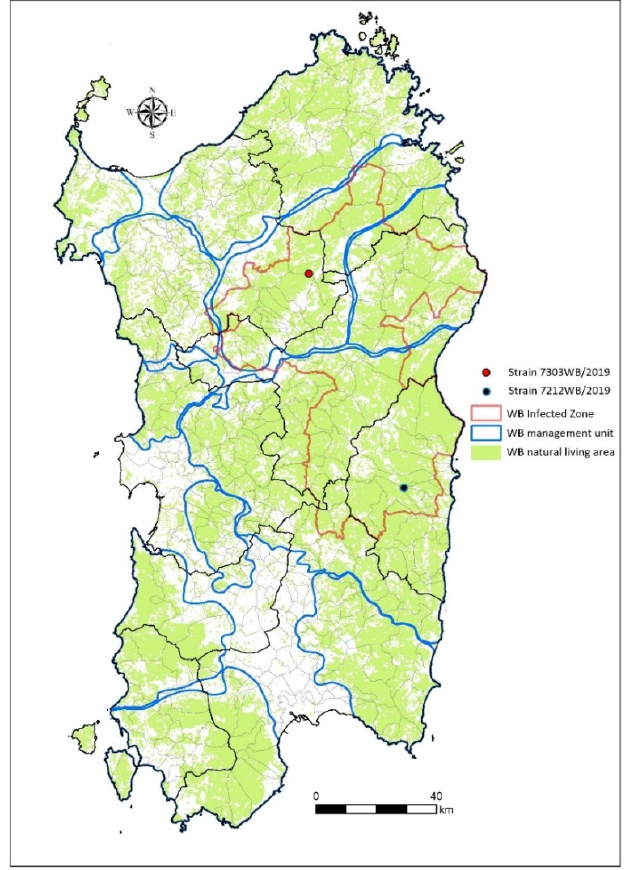
Figure 1. The map represents the locations of the two wild boars analyzed in this study, which were sampled in Sardinia during the 2018–2019 hunting season. The blue lines indicate the wild boar (WB) hunting management unit (HMU), while the red line indicates the limits of the WB-infected zone in 2019.